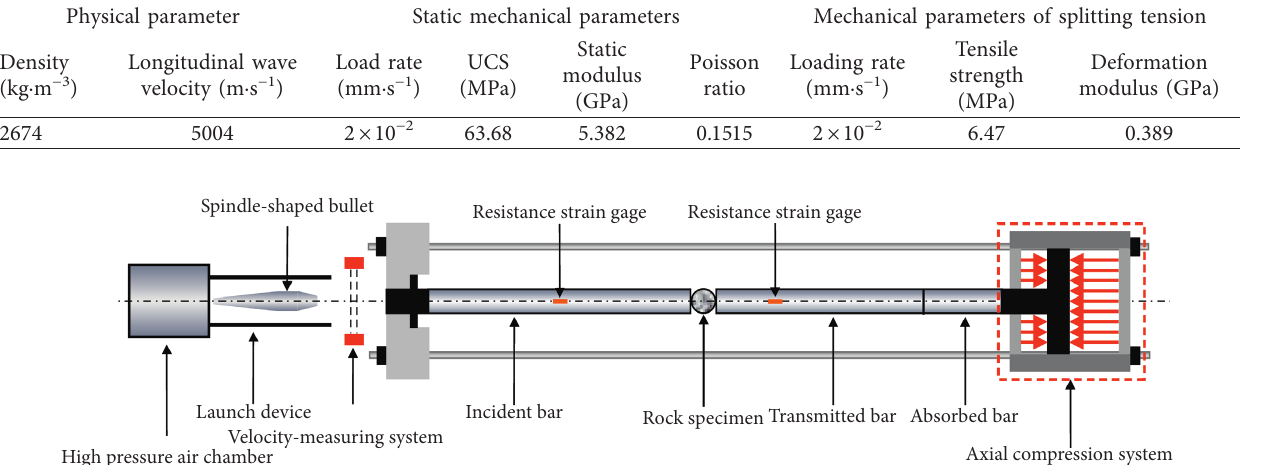
Figure 1: Coupled static and dynamic loading equipment for disk